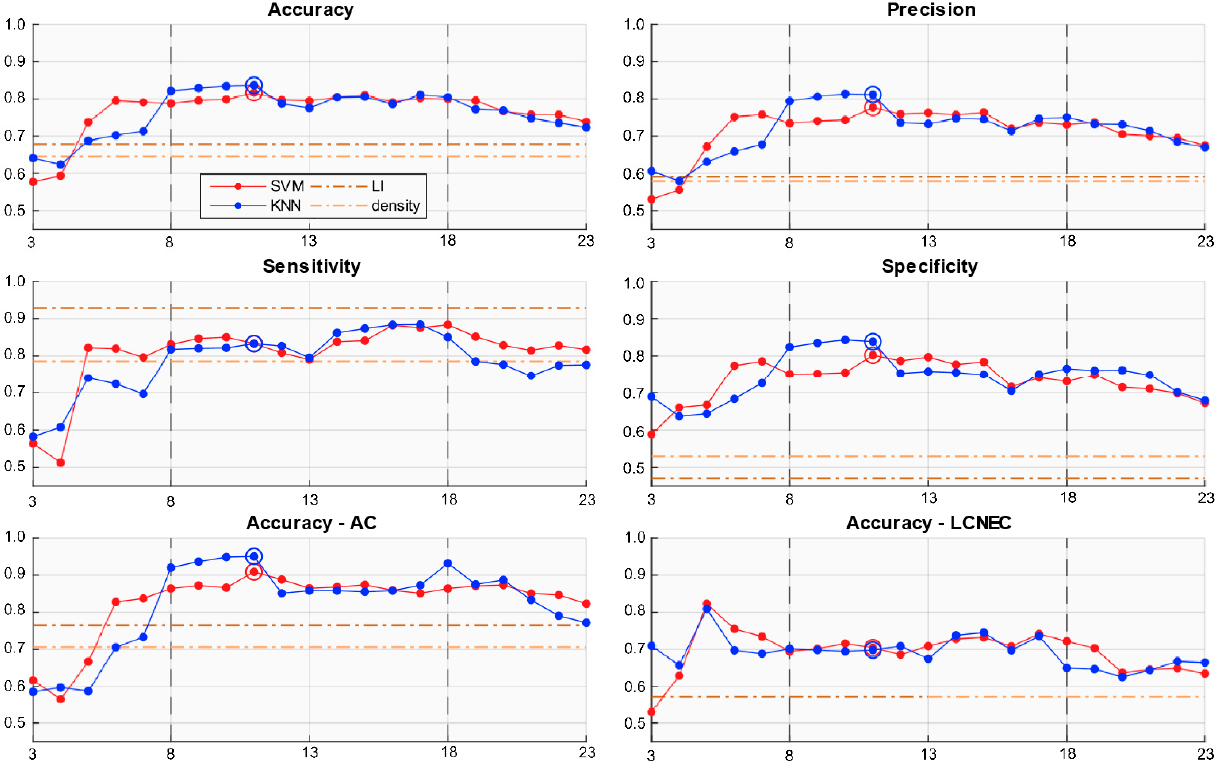
Figure 4. Comparisons of performance metrics between our k-NN and SVM models and the classifiers based on Ki-67 Labelling Index and Ki-67 + cell density. The horizontal axes of the plots indicate the number of top prognostically relevant features employed by our models, ranging from top 3 to top 23. The circles are placed in correspondence to the individual models that obtained the best accuracy; for both k-NN and SVM, these correspond to the model that employed 11